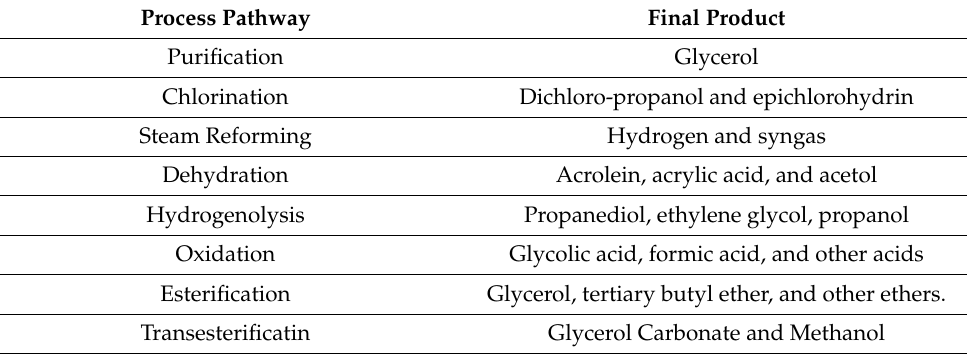
Table 1. Different processes for utilization of crude glycerol.